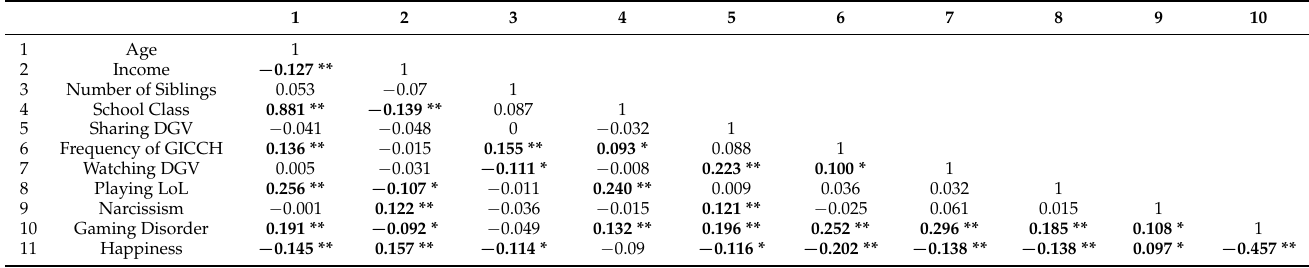
Table 3. Correlations.